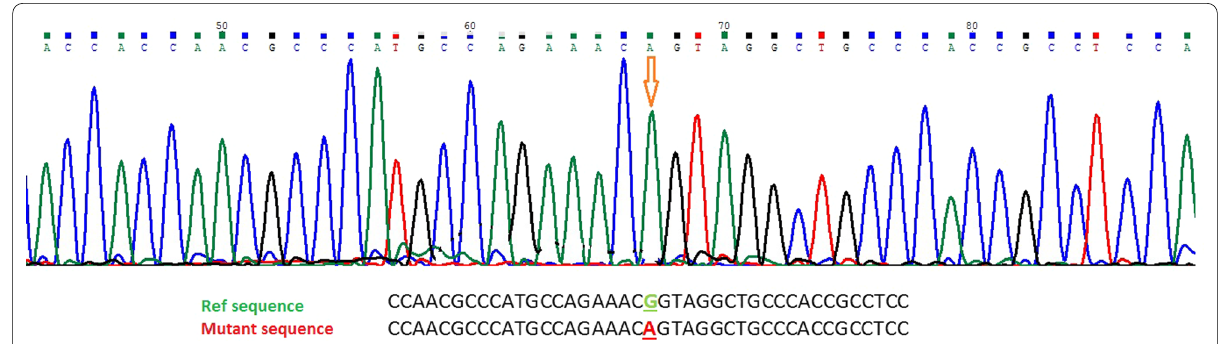
Fig. 1 Homozygous mutation of c.319G>A (p.Ala107Thr) in GALNS gene in the